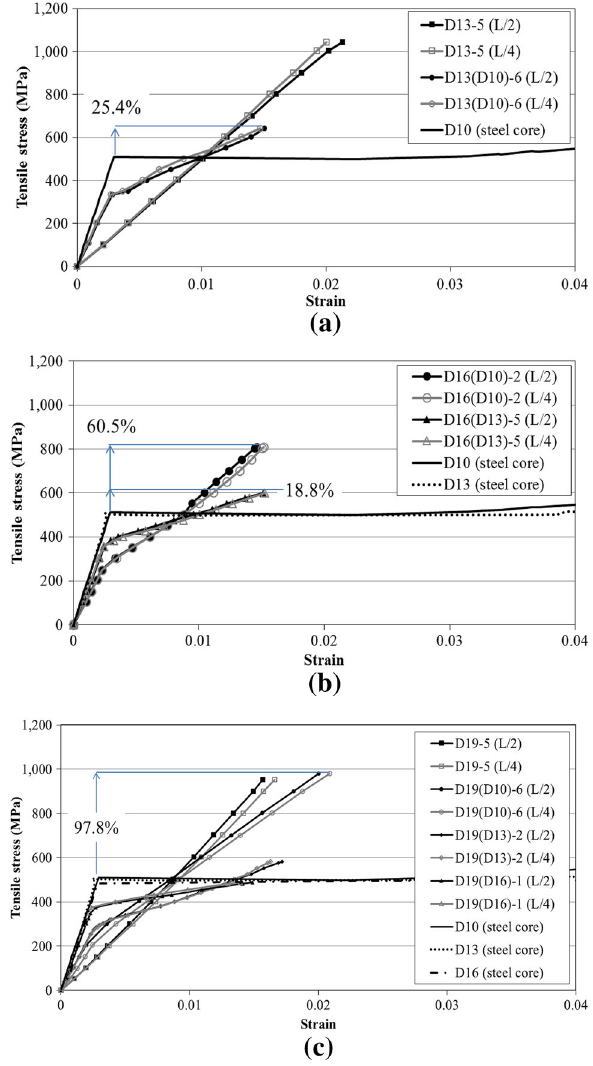
Fig. 6 Tensile stress–strain relationships of the GFRP hybrid bars. a D13 specimen series, b D16 specimen series, c D19 specimen series